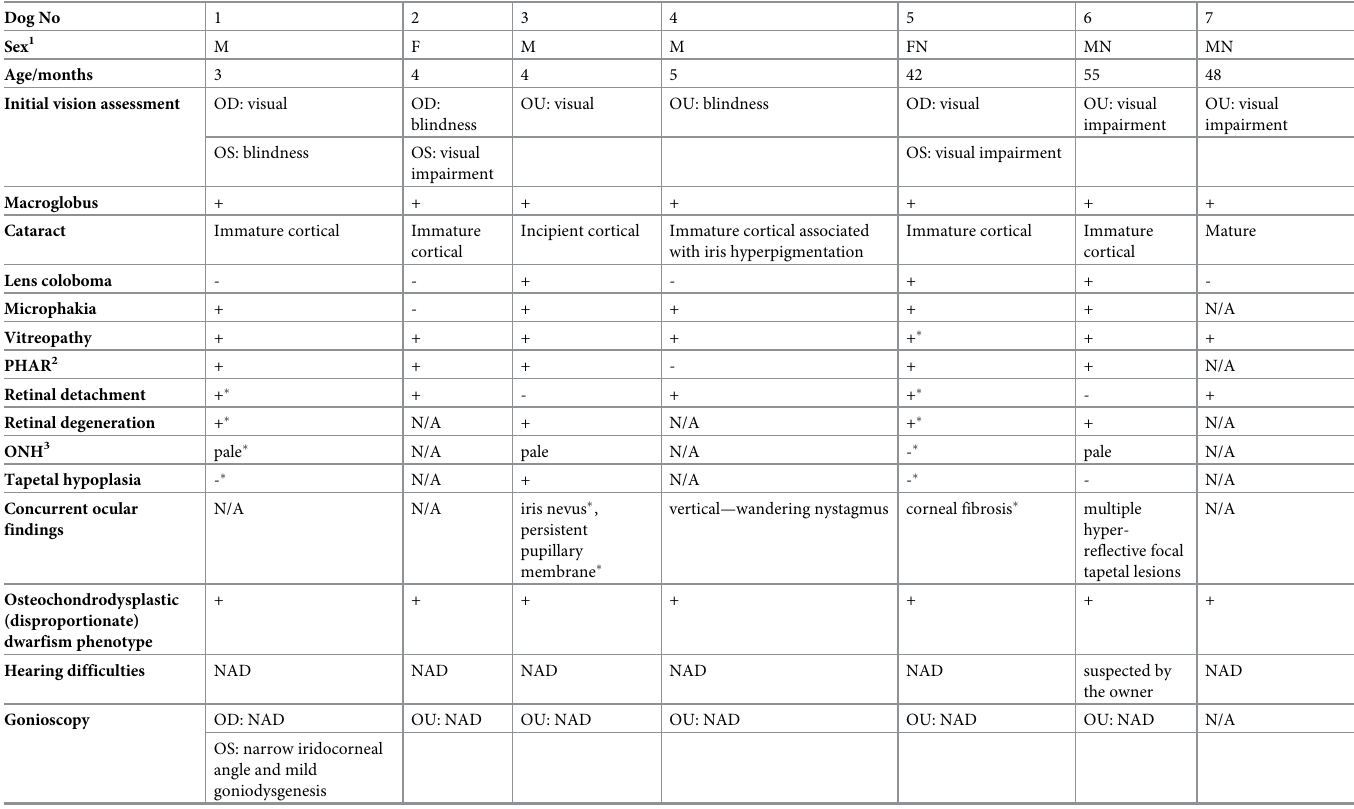
Table 1. Clinical investigation of seven OSD affected